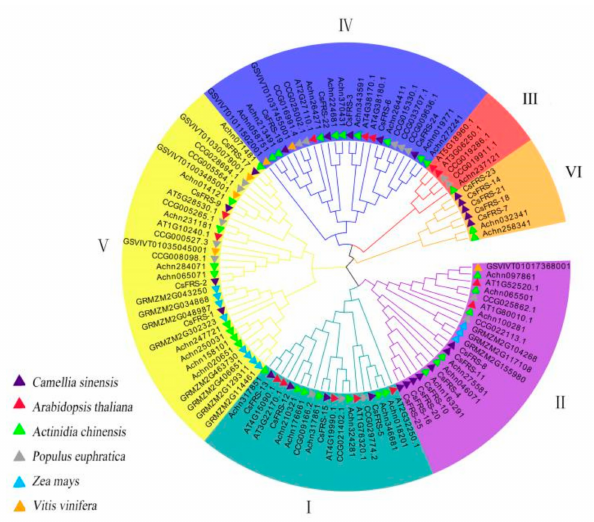
Figure 1. Phylogenetic analysis of the CsFHY3/FAR1 family in tea, Arabidopsis, grape, poplar, maize, and kiwifruit.